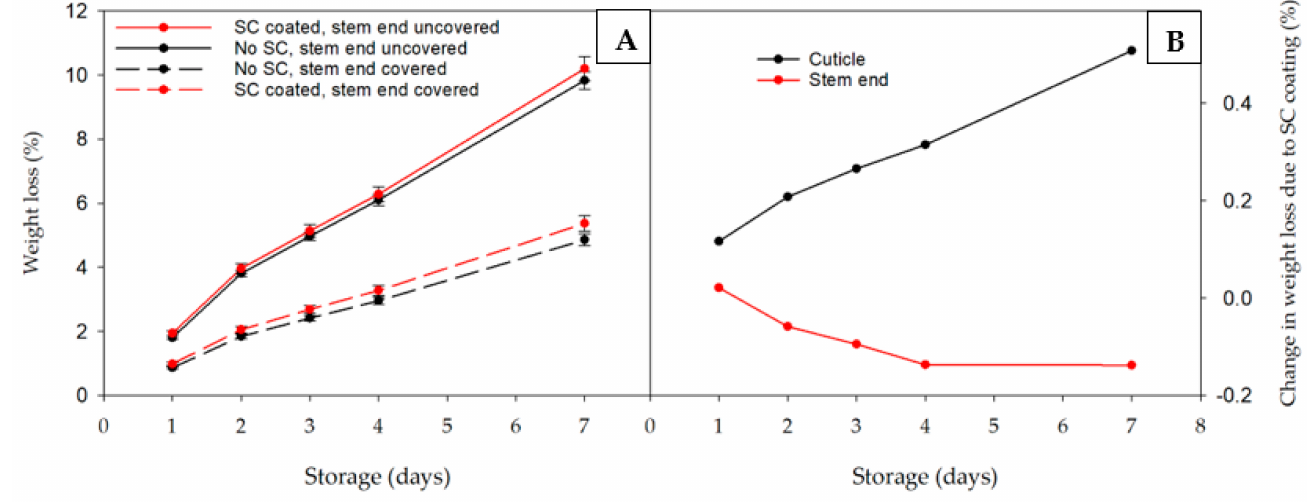
Figure 2. Effect of coating with sodium caseinate (SC) and coverage of the stem end of ‘San Joaquin’ blueberries with nail polish on weight loss during 7 d storage at 20 ◦ C ( A ) and change in weight loss due to SC in either the cuticle or stem end ( B